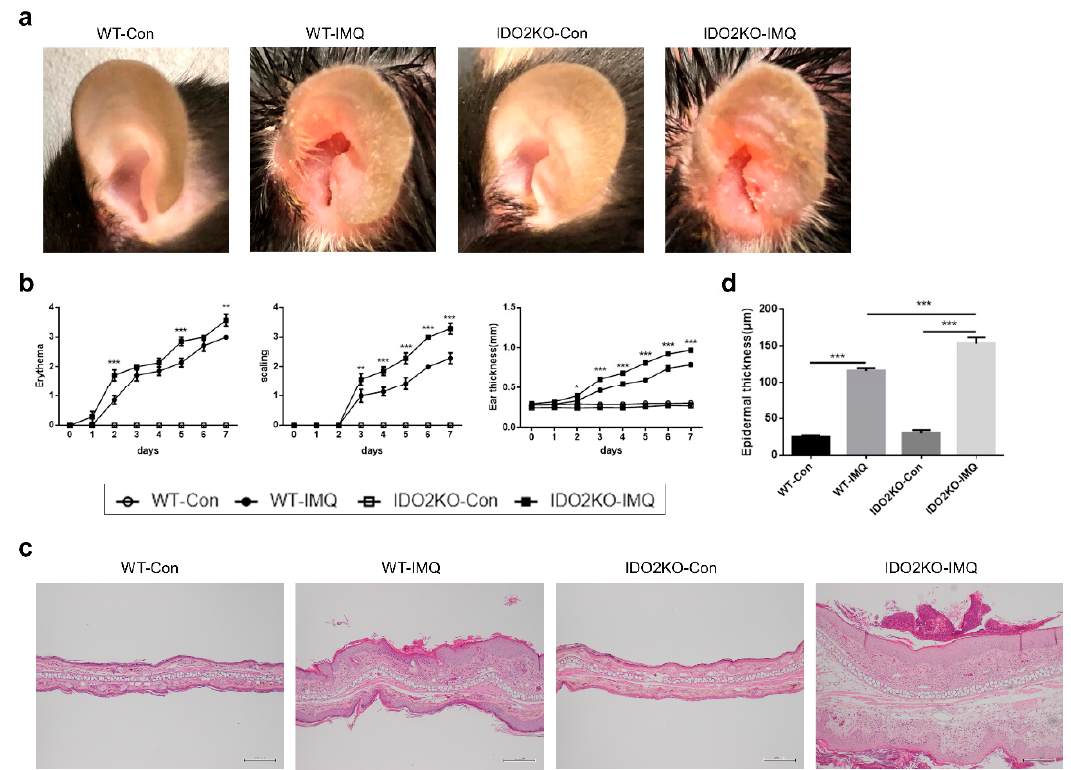
Figure 2. IMQ-induced psoriasis-like inflammation is significantly more severe in IDO2 KO mice. ( a ) Macroscopic phenotypic representation of the left ear in WT and IDO2 KO mice treated with vehicle or IMQ for 7 days. ( b ) Erythema, scaling, and thickness of the ear were evaluated daily (0 = none, 1 = slight, 2 = moderate, 3 = marked, 4 = very marked). Data are representative of three independent experiments. * p < 0.05, ** p < 0.01, *** p < 0.001 when comparing IDO2 KO-IMQ to WT-IMQ (two-way